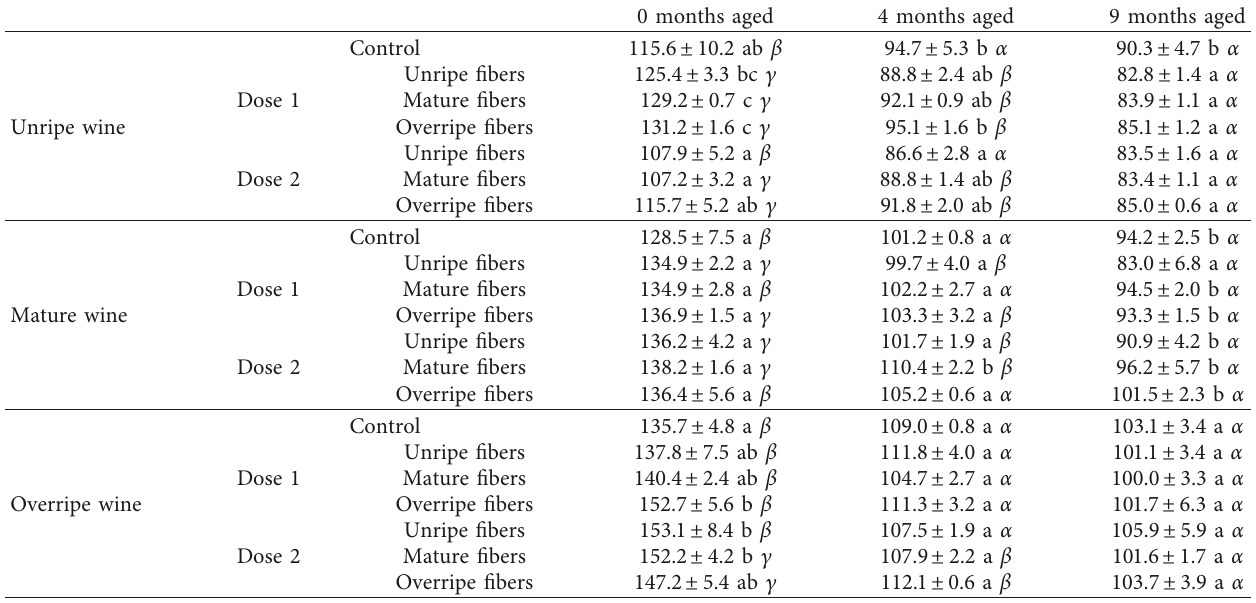
Table 3: Total anthocyanin content of the wines expressed as mg/L of malvidine- O